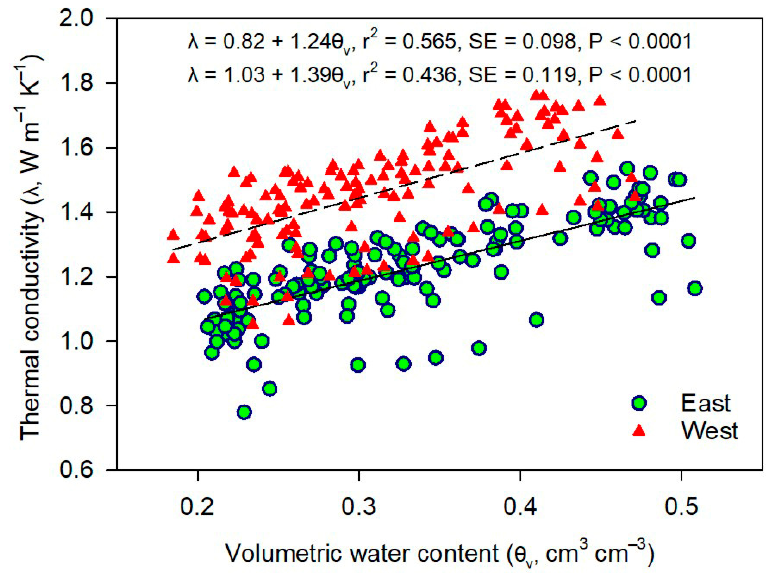
Figure 6. Relationship between soil thermal conductivity ( λ ) and volumetric water content ( θ v ) within the 0–20 cm soil depth for all pasture treatments in the east (solid line) and west (dashed line) area during a 2-year study period (2016–2017). The θ v is a function of applied pressure heads given by measured soil water retention curves (SWRCs) (Figure 4). Data pooled from years, depths, and pressure heads applied for determining SWRCs.